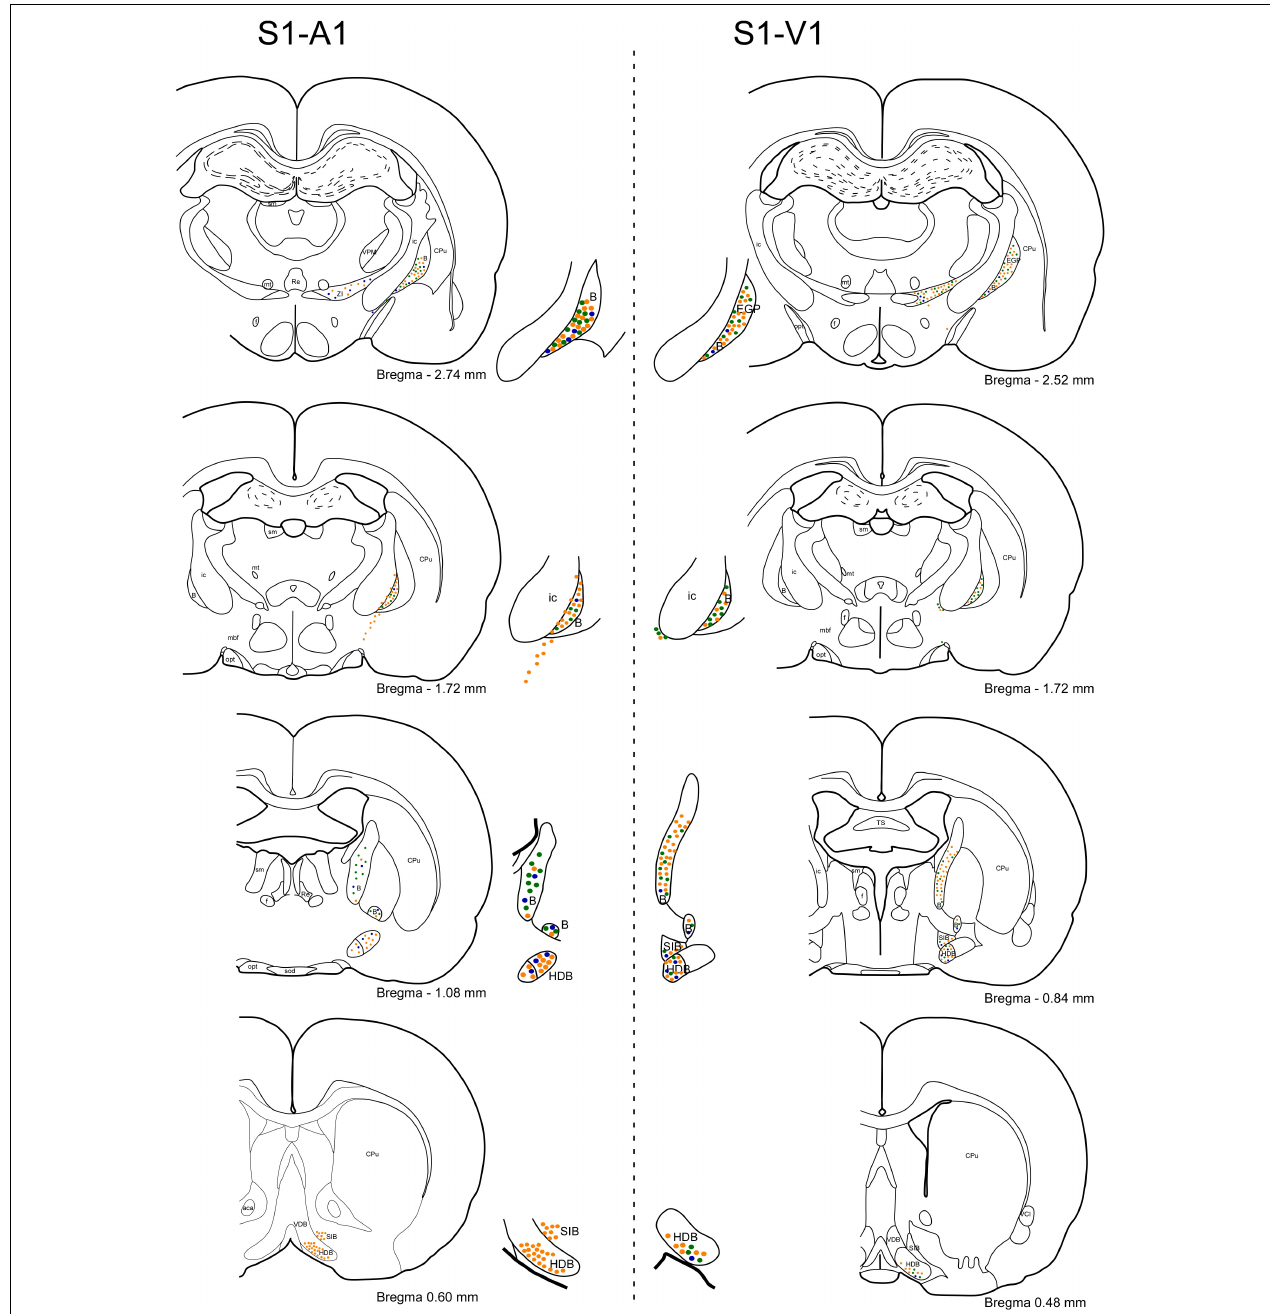
FIGURE 5 | Rostral to caudal schematic drawings of brain coronal sections of BF neurons projecting to S1, A1, and V1 cortices. Neurons projecting to S1 or/and A1 cortices are shown on the left column (o similar) of the figure and to S1 or/and V1 cortices on the right column of the figure. Neurons are depicted as: single-FG (orange, injection in S1), single-FB (blue; injection in A1), single-FB (blue; injection in V1), and double-labeled neurons (green). Notice the different location in the BF nuclei of neurons projecting to S1, A1, or V1 cortices. 3V, 3rd ventricle; aca, anterior commissure; CPu, caudate putamen; EGP, external globus pallidus; Re, reuniens thalamic nucleus; SIB, substantia innominate basal part; SO, supraoptic nucleus; VCl, ventral part of claustrum.